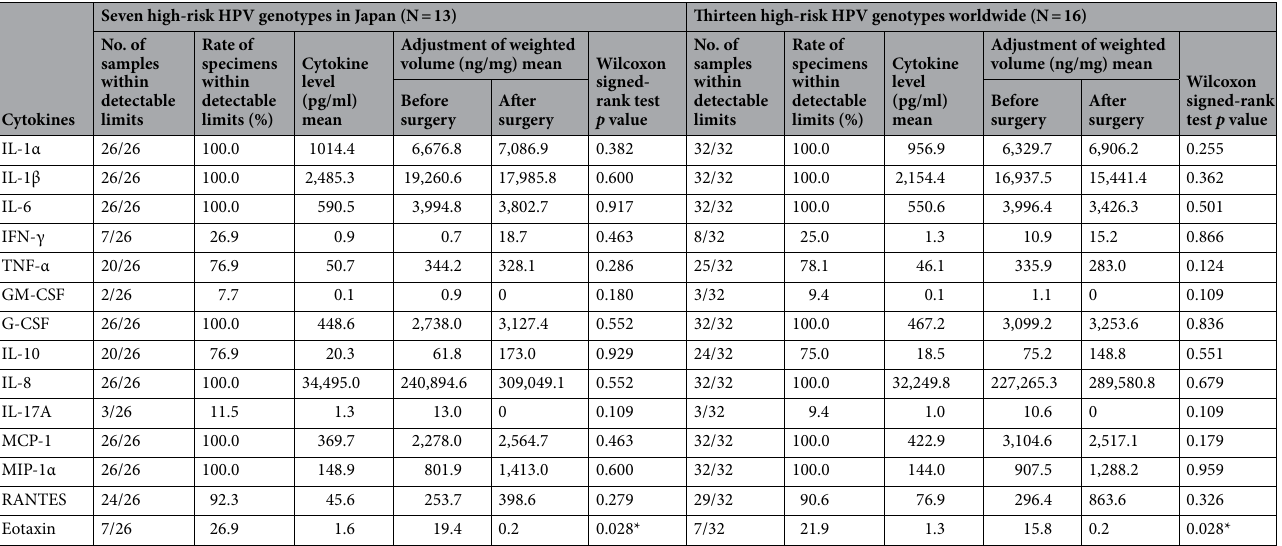
Table 6. Time course for cytokine levels in patients with 7 or 13 high-risk HPV genotypes before surgery, but none after surgery. Seven high-risk HPV genotypes in Japan; HPV 16, 18, 31, 33, 45, 52, and 58. 13 high-risk HPV genotypes worldwide; HPV 16, 18, 31, 33, 35, 39, 45, 51, 52, 56, 58, 59, and 68. * p < 0.05 by Wilcoxon signed-rank